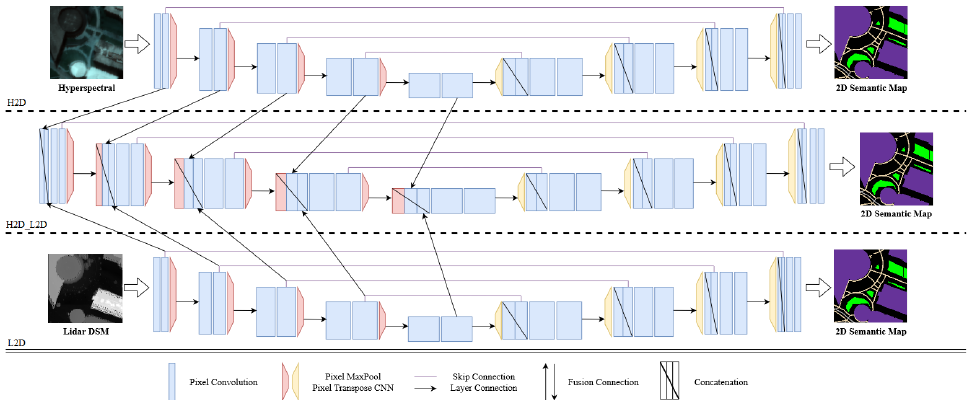
Figure 5. Pixel convolution-based networks. ( Top ) H2D ingesting raw hyperspectral data and predicting a 2D semantic map. ( Bottom ) L2D ingesting a lidar DSM and predicting a 2D semantic map. ( Center ) H2D_L2D ingesting low- and high-level unimodal hyperspectral and lidar features via fusion connections from H2D and L2D and predicting a 2D semantic map. H2D_L2D is constructed as a composite style fusion architecture inspired by [17].